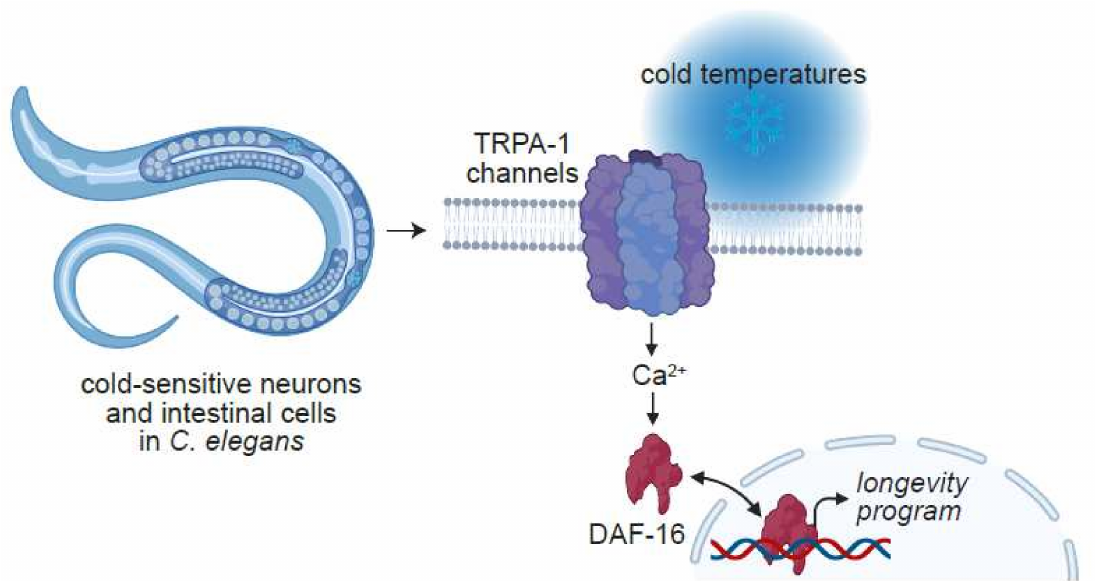
Figure 7. Effect of low-temperature on the lifespan of C. elegans is mediated by the cold-sensitive ion channel, TRPA-1. TRPA-1 is a cold sensitive ion channel that resides in the plasma membrane of C. elegans neurons and intestinal cells. Activation of the channels at 15 ◦ C, results in cytosolic Ca 2+ elevation and the activation of a signaling cascade that culminates in DAF-16/FOXO-mediated gene transcription, which in turn, promotes worm longevity. Image created with BioRender.com (accessed 27 January